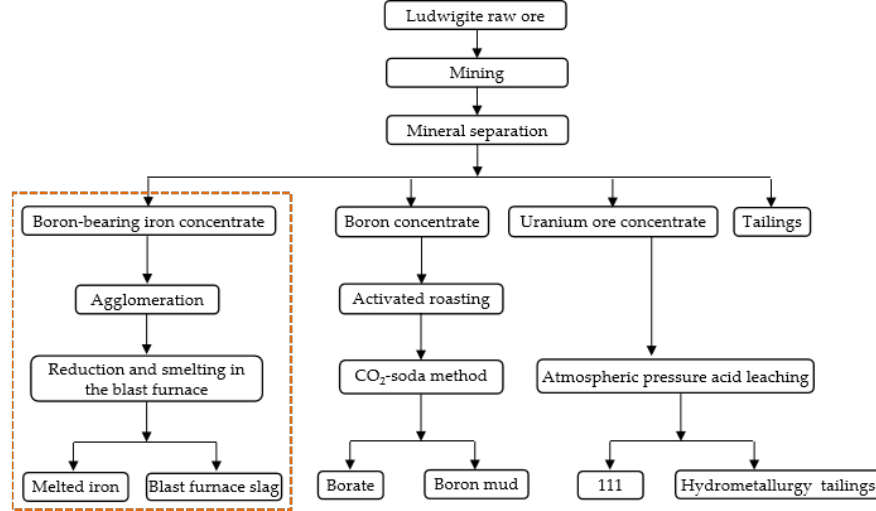
Figure 1. Present, predominantly utilized route of ludwigite ore.